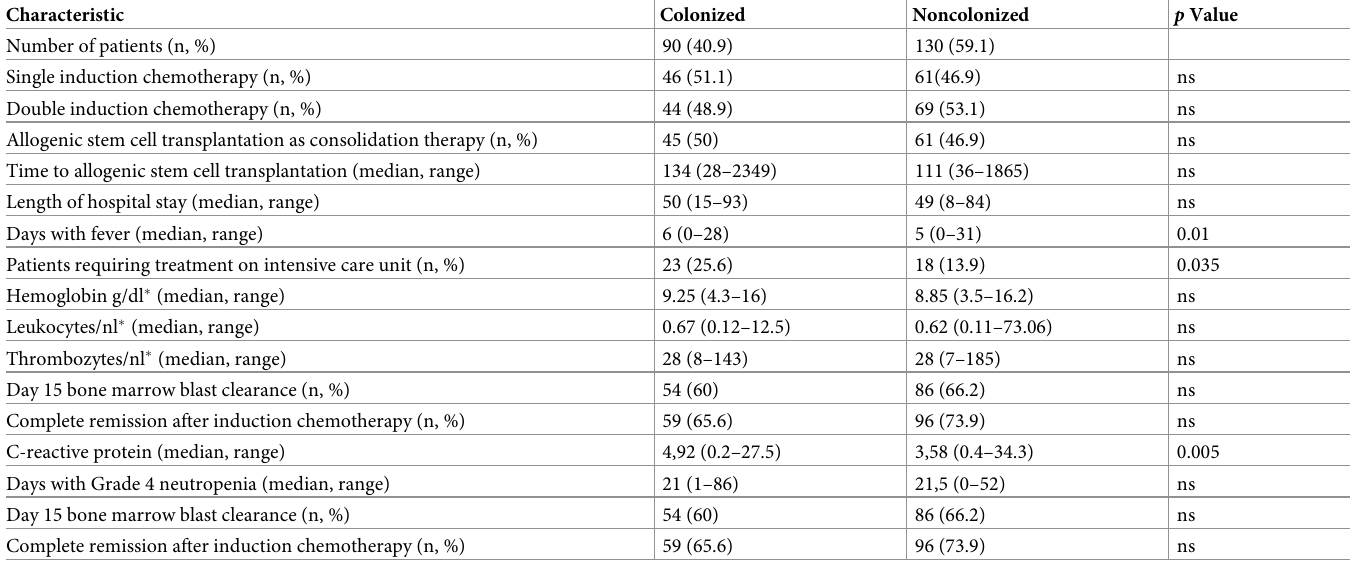
Table 3. Clinical findings.